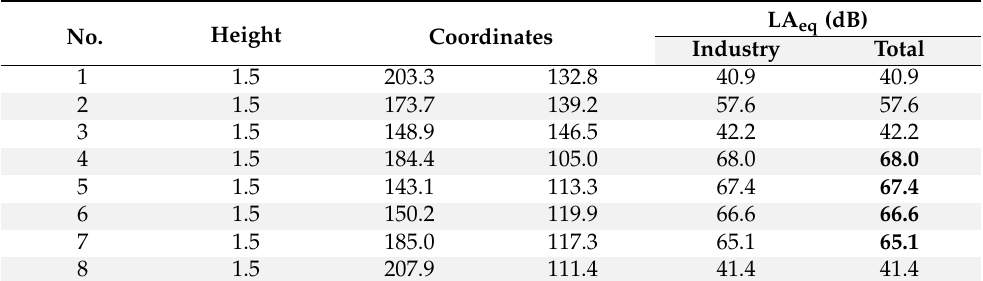
Table 11. Table of points from the calculation of measured points for earthworks in the investi- gated area.